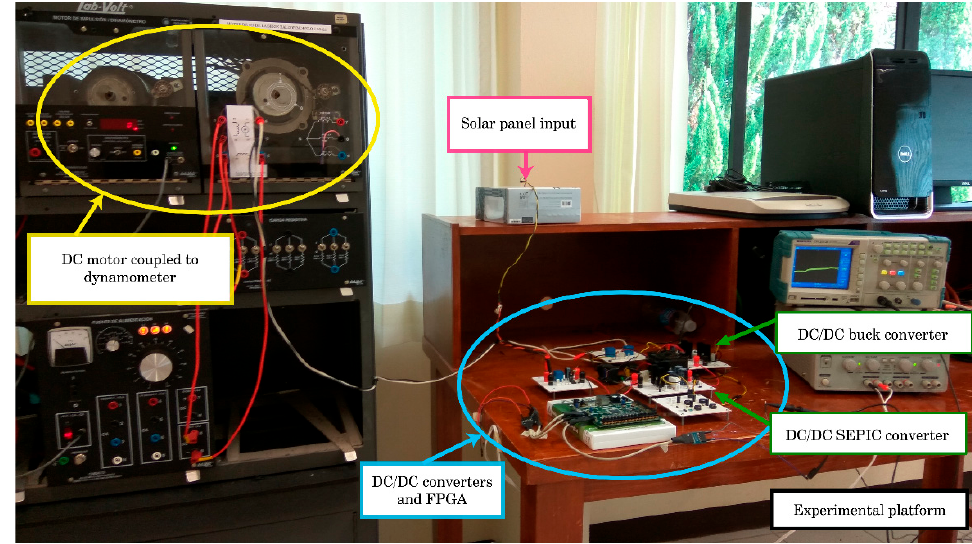
Figure 17. Experimental prototype of the PV system.